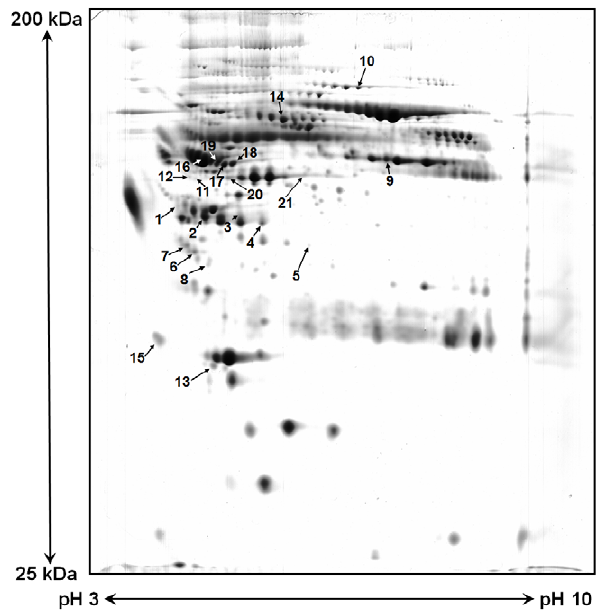
Figure 1. A representative 2D gel of plasma proteins from a long term HD patient. Plasma proteins were pre-treated with